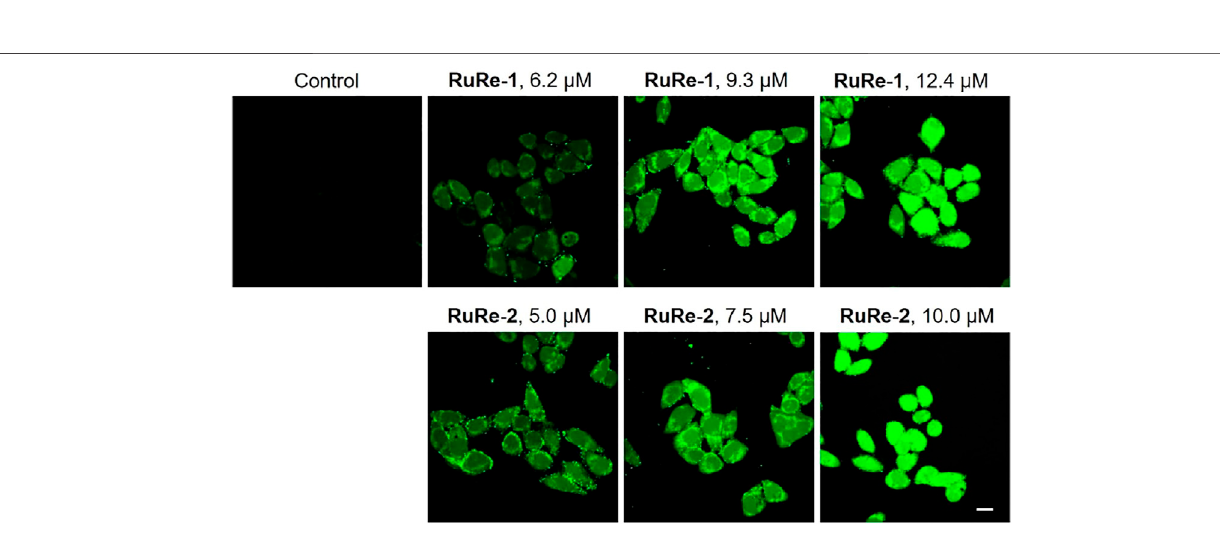
Frontiers in Chemistry |